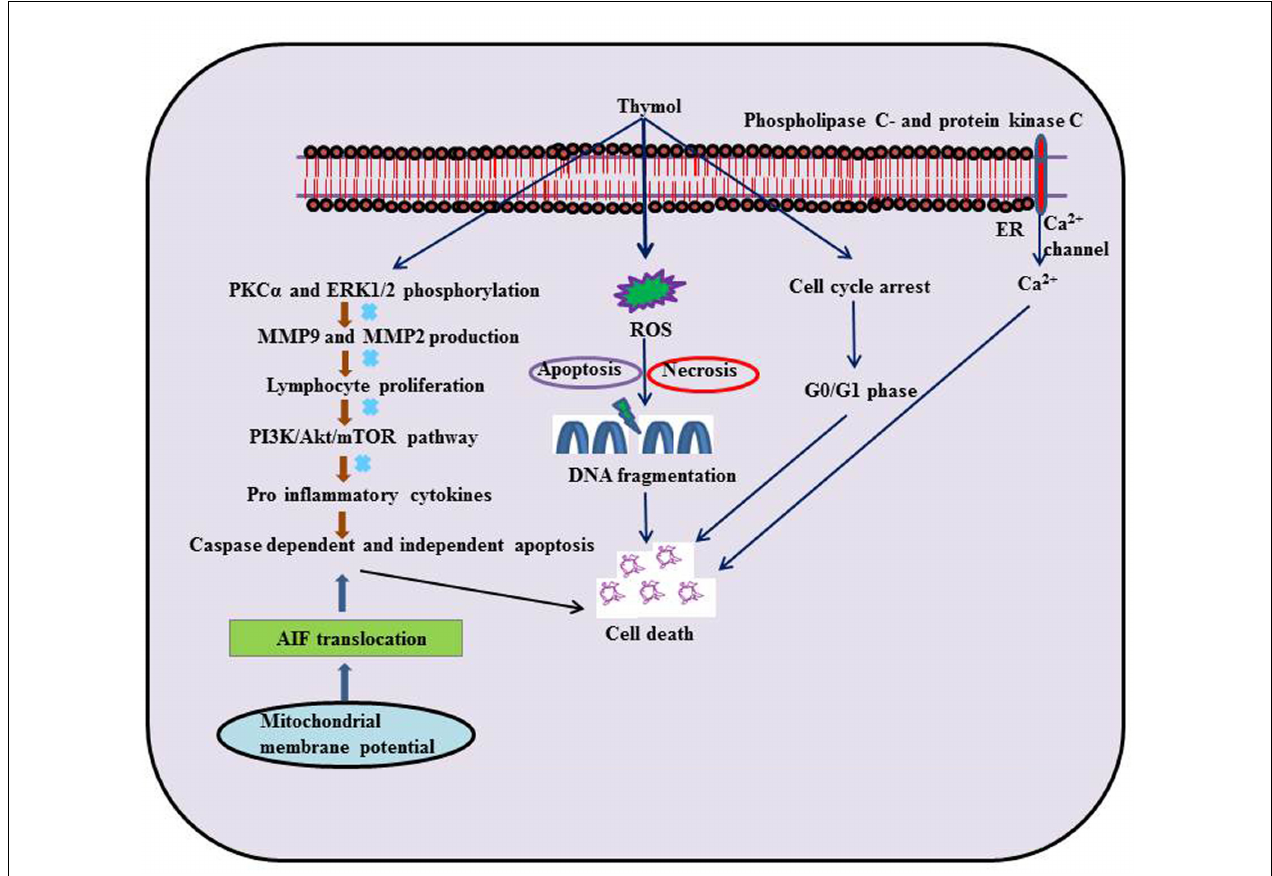
FIGURE 1 | Schematic representation on the effects of thymol in different experimental models of